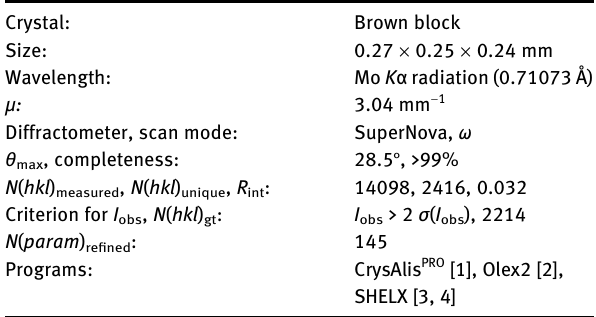
Table  : Data collection and